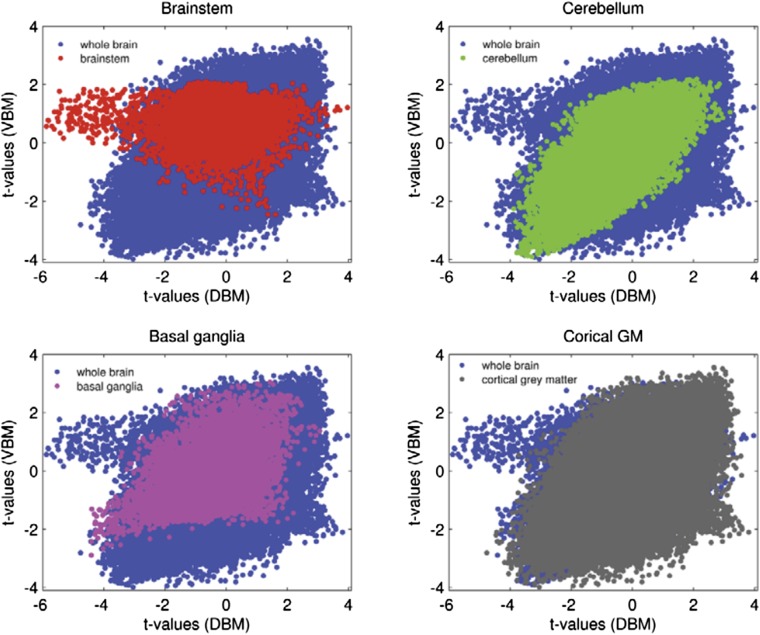
DOI:
http://dx.doi.org/10.7554/eLife.08440.023